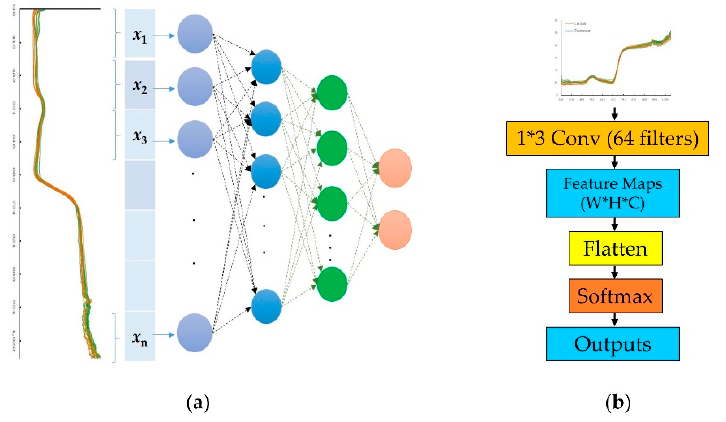
Figure 2. Illustration of the 1D-CNN: ( a ) The network comprised an input layer (light purple circles) transformed from the input spectra (far left), a feature layer (blue circles), a fully connected layer (green circles), and an output layer (orange circles) that represented the classification results (“normal” or “early drought stress” physiological status); ( b ) hierarchical layer flow of the 1D-CNN model. W, H, and C represent the width, height, and number of channels of the feature map, respectively.